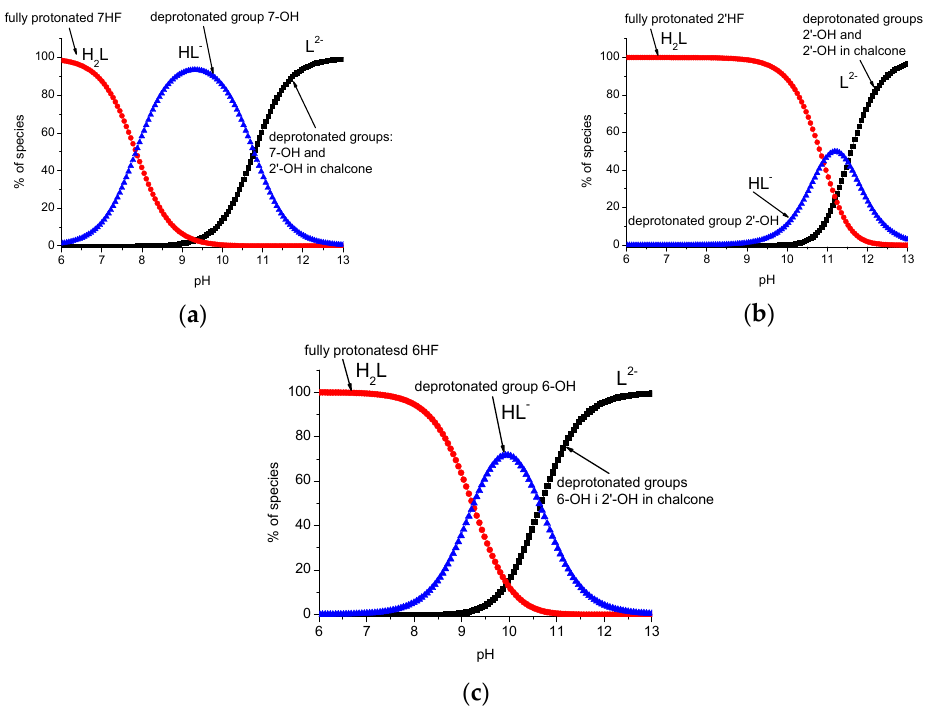
Figure 11. Species distribution diagram showing the species of ( a ) 7HF, ( b ) 2’HF and ( c ) 6HF formed as a function of pH. All reactants are 1 × 10 − 3 M in concentration.